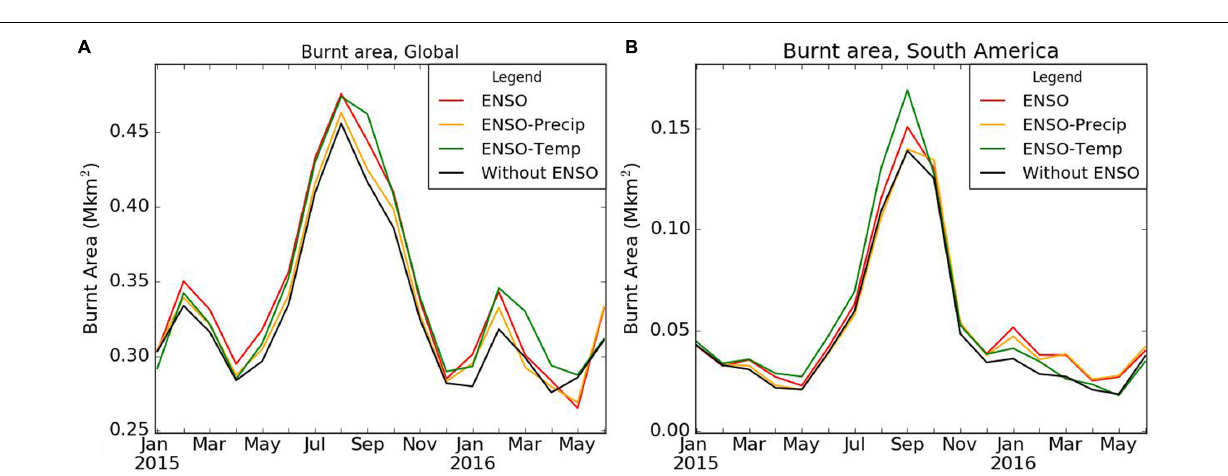
FIGURE 7 | Change in flammability due to El Niño for trees (A) and grasses (B) simulated by JULES-INFERNO.